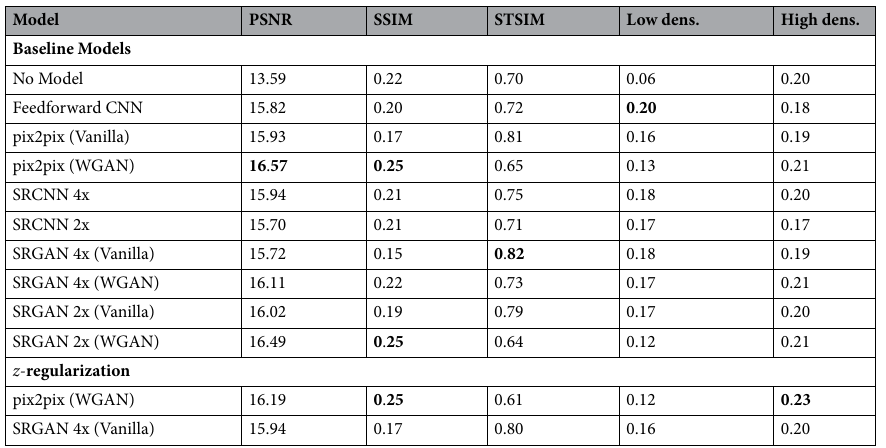
Table 1. Paired image similarity results. Comparison of image reconstruction models for 2D-to-2D image translation. Metrics are calculated using 100 image patches sized 128 × 128 pixels sampled from held-out test set images. A greater score is better for all metrics shown. The feedforward CNN and pix2pix model use a 9-block ResNet for image translation 37 and the SRCNN and SRGAN models use a 9-block super-resolution ResNet 34 . The pix2pix (WGAN) model performs the most strongly in terms of PSNR, SSIM, and high- density region segmentation. The SRGAN 4x (Vanilla) model performs the most strongly in terms of STSIM (perceptual similarity) and second most strongly for low-density region segmentation. The z -regularization slightly reduces performance for all metrics except high-density region segmentation.